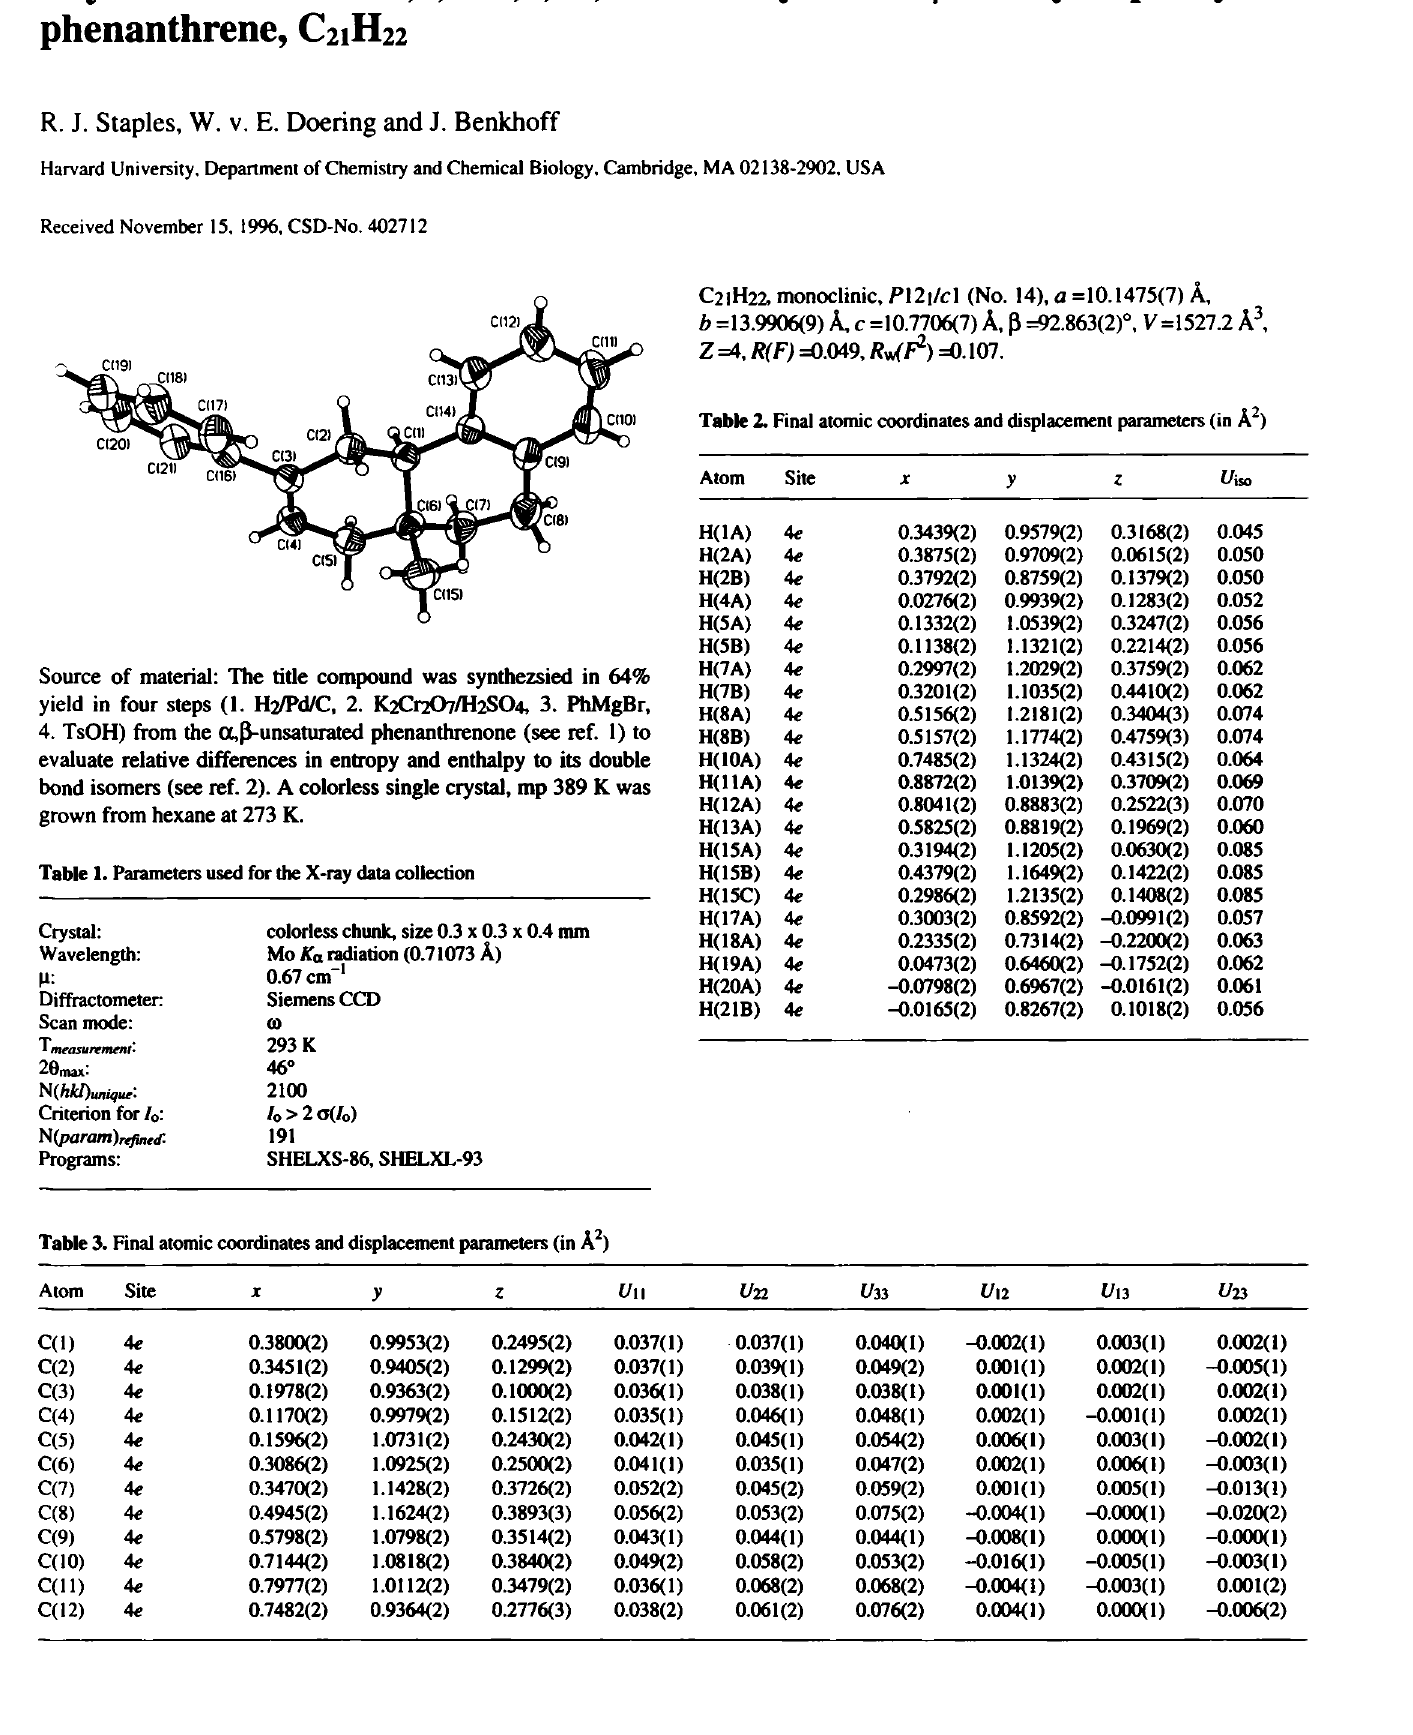
Table 2. Final atomic coordinates and displacement parameters (in A 2 )